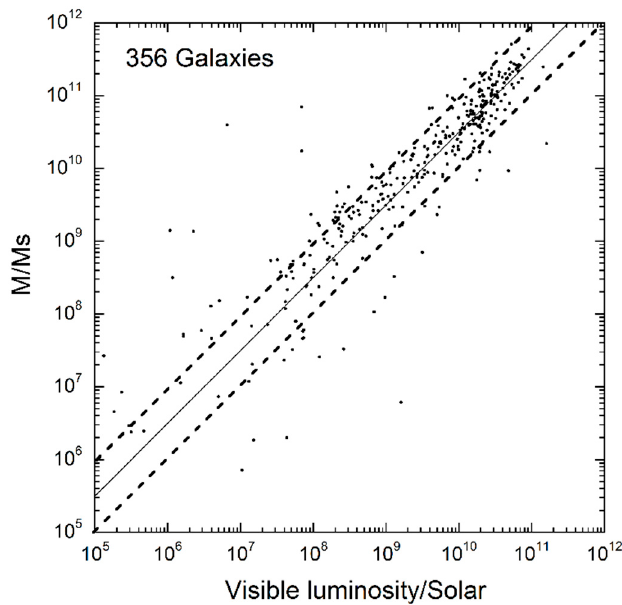
Figure 2. Direct determination of galactic mass interior to the visual edge, using Equation (8) and the 356-galaxy data set of [7]. The calculated mass M and measured visible luminosity of each galaxy are normalized to Solar values. Most calculated masses are about 3 × larger than the normalized luminosity (solid line); the parallel dashed lines are for equal values, and 10 × equal values.